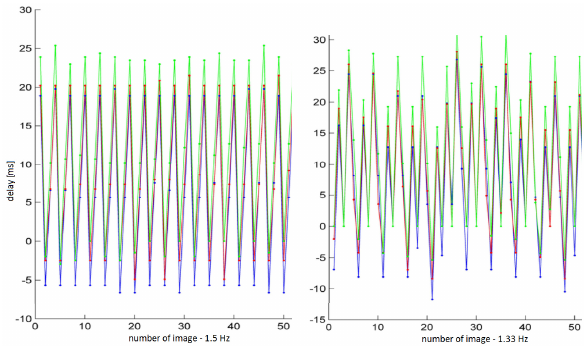
Figure 14. Evolution of time delay for individual images with rotation frequency 1.5 Hz and 1.33 Hz